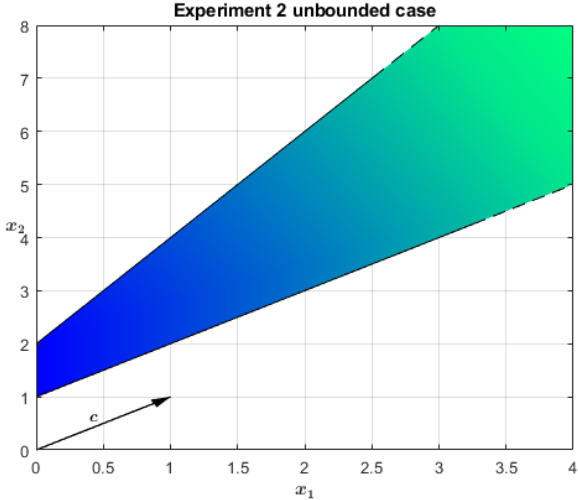
Figure 3. Example of an unbounded primal polyhedron.